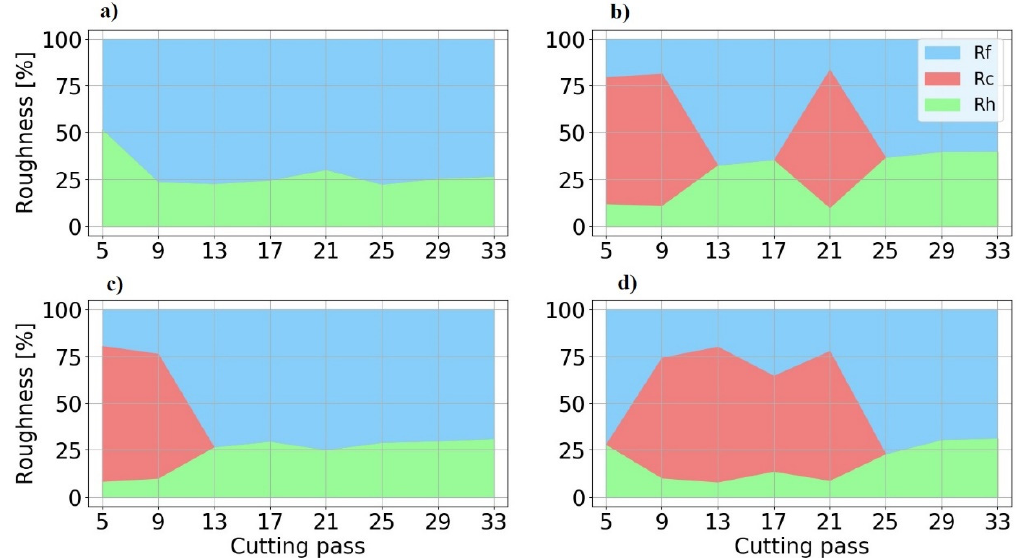
Figure 13. Average roughness components per cutting pass. ( a ) TP10. ( b ) TP08. ( c ) TP04. ( d ) TP02.